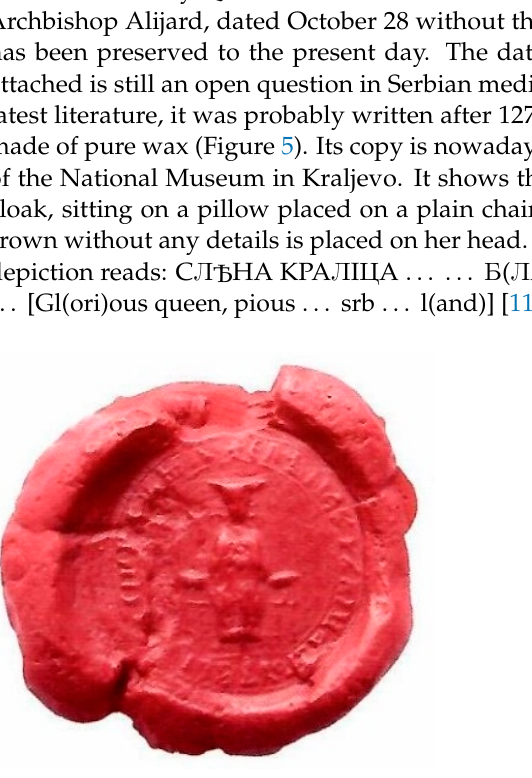
Figure 5. Queen Helen represented as a ruler. Replica of the wax seal, Collection of Seal Replicas No. 133. National Museum in Kraljevo. Photo by Sr đ an Vulovi ć , courtesy of the National Museum of Kraljevo.